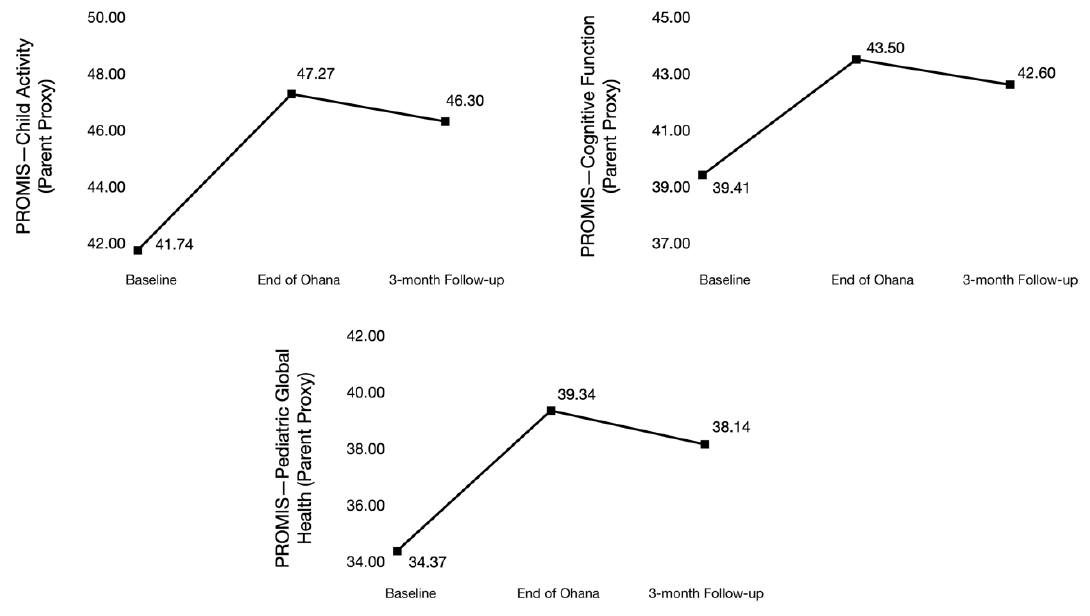
Figure 4. Changes in T-scores for exploratory outcomes for pediatric brain tumor patients.